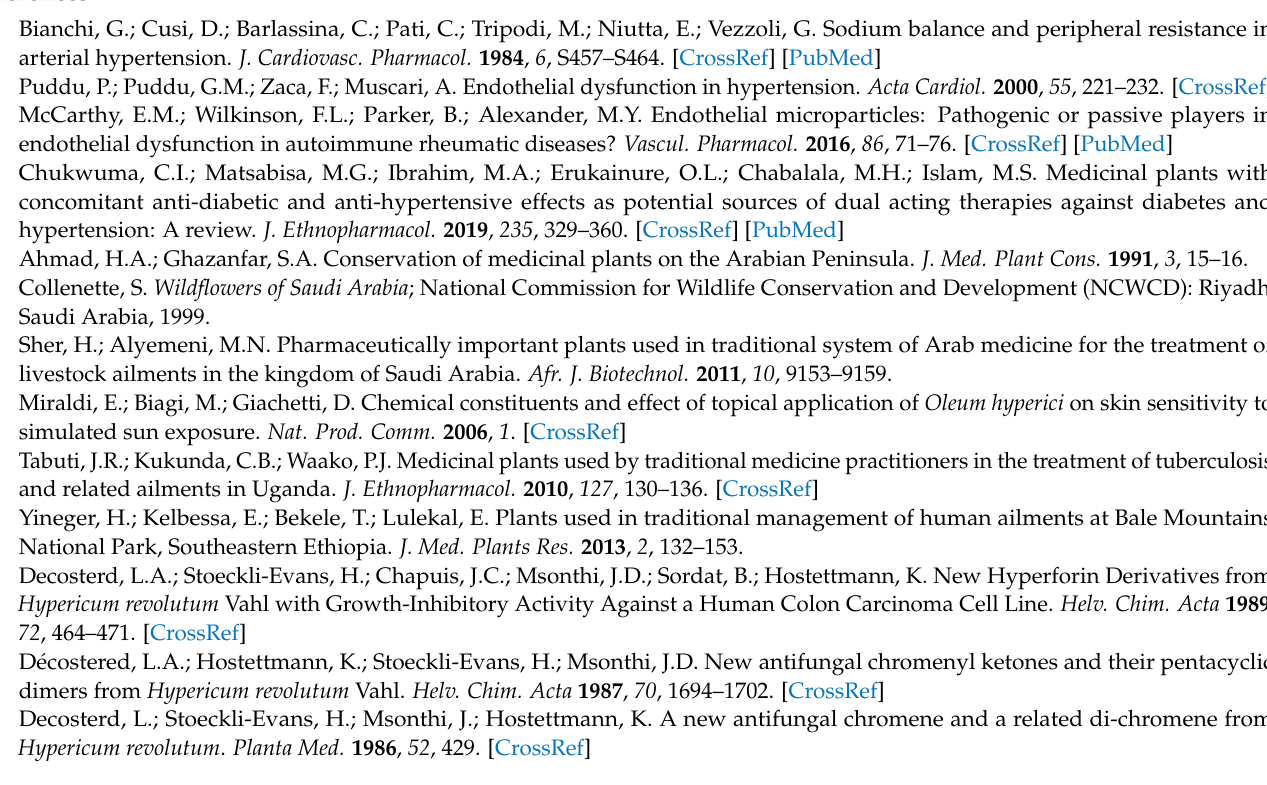
spectrum of compound 2 (CDCl 3 , 850 Hz), Figure S8: 13 C NMR spectrum of compound 2 (CDCl 3 , 214 Hz), Figure S9: HSQC spectrum of compound 2 , Figure S10: HMBC spectrum of compound 2 , Figure S11: COSY spectrum of compound 2 , Figure S12: NOESY spectrum of compound 2 , Figure S13: 1 H NMR spectrum of compound 3 (CDCl 3 , 850 Hz), Figure S14: 13 C NMR spectrum of compound 3 (CDCl 3 , 214 Hz), Figure S15: 1 H NMR spectrum of compound 4 (euxanthone) (CDCl 3 , 850 Hz), Figure S16: 13 C NMR spectrum of compound 4 (euxanthone) (CDCl 3 , 214 Hz), Figure S17: HSQC spectrum of compound 4 (euxanthone), Figure S18: HMBC spectrum of compound 4 (euxanthone), Figure S19: 1 H NMR spectrum of compound 5 (2,3,4-tirmethoxy xanthone) (CDCl 3 , 850 Hz), Figure S20: 13 C NMR spectrum of compound 5 (2,3,4-tirmethoxy xanthone) (CDCl 3 , 214 Hz), Figure S21: HSQC spectrum of compound 5 (2,3,4-tirmethoxy xanthone), Figure S22: HMBC spectrum of compound 5 (2,3,4-tirmethoxy xanthone), Table S1: NMR data of compound 3 (CDCl 3 , 850 and 214 Hz), Table S2: NMR data of compound 4 (euxanthone) (CDCl 3 , 850 and 214 Hz), Table S3: NMR data of compound 5 (2,3,4-tirmethoxy xanthone) (CDCl 3 , 850 and 214